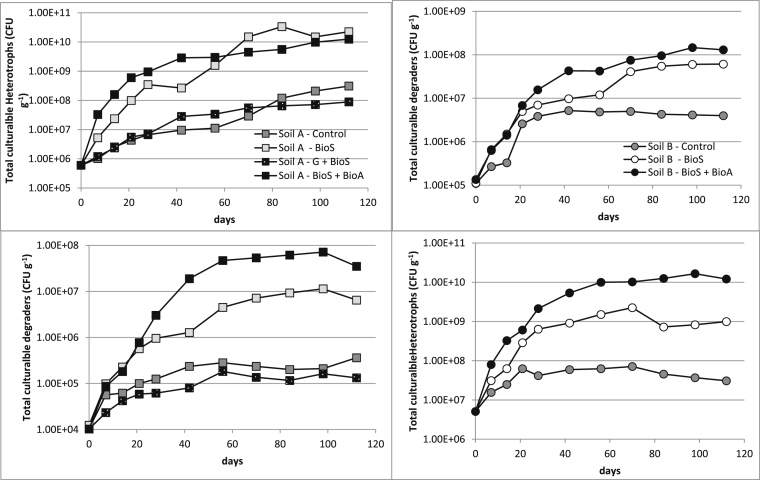
Total culturable heterotroph and degrader numbers over 112 days (Standard deviation was <20% for both CFU counts and not shown on the graphs for clarity).